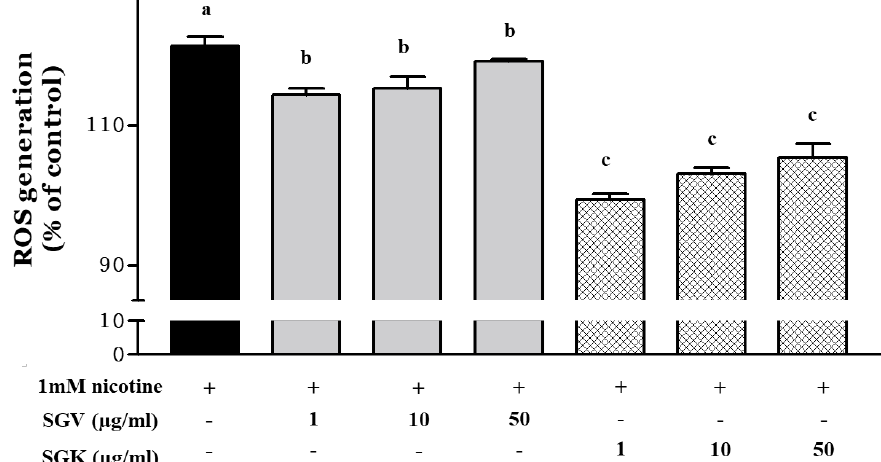
Figure 5. Inhibition of reactive oxygen species (ROS) generation in HepG2 cells pretreated with various concentrations of SGV and SGK prior to induction of cytotoxicity by 1 mM nicotine. Different letters represent a significant difference at p < 0.05. + means with treatment and - means without treatment.